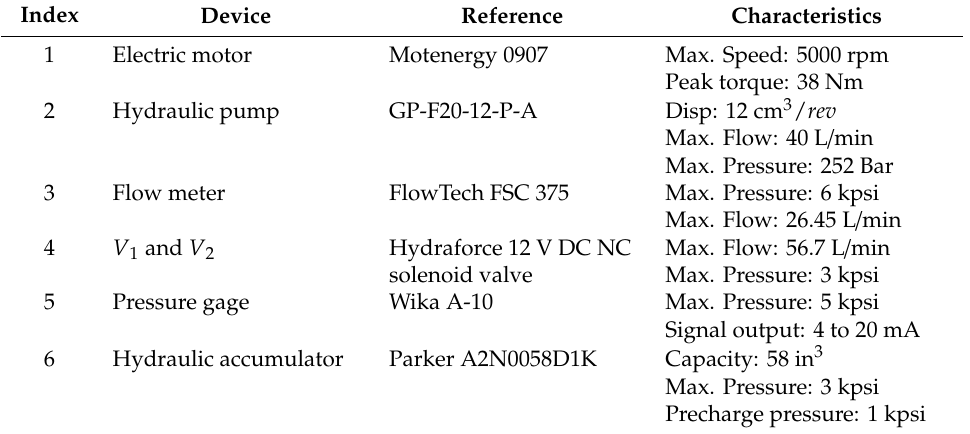
Figure 3. Schematic representation for the hydraulic accumulator test bench. Table 3. List of components used in the hydraulic test bench.